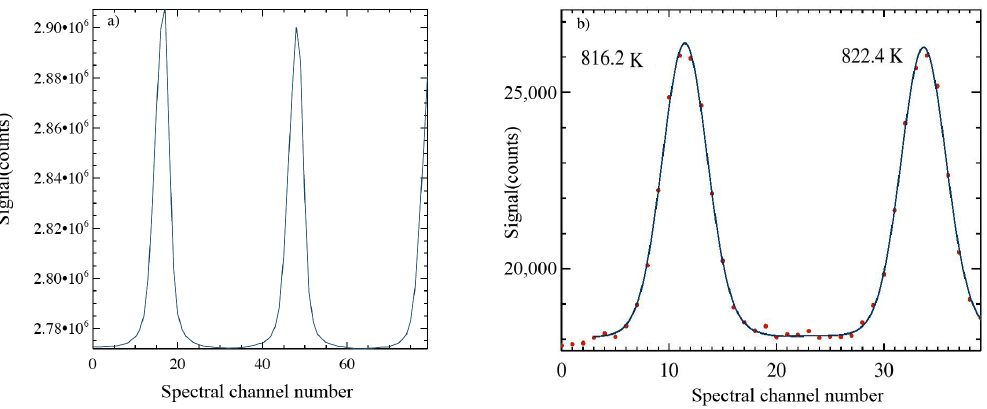
Fig. 3. Two examples of summed spectra for the laser (a) and 630-nm nightglow images (b) obtained for observations on 7 April 2005. The exposure time for each image was 240s. The red dots in the nightglow spectrum represent the signal determined by the addition of the pixel signals within each equal-area annulus. Seventeen data points were used in the analysis for each order. Temperature values determined by the fit are indicated in the figure as 816.2K and 822.4K. Ninety annular rings were used for the laser plot to illustrate the line shape more precisely; in the Fourier analysis described in the text, the laser profile would be determined using 17 annular rings. The finesse for the laser interferogram is ∼